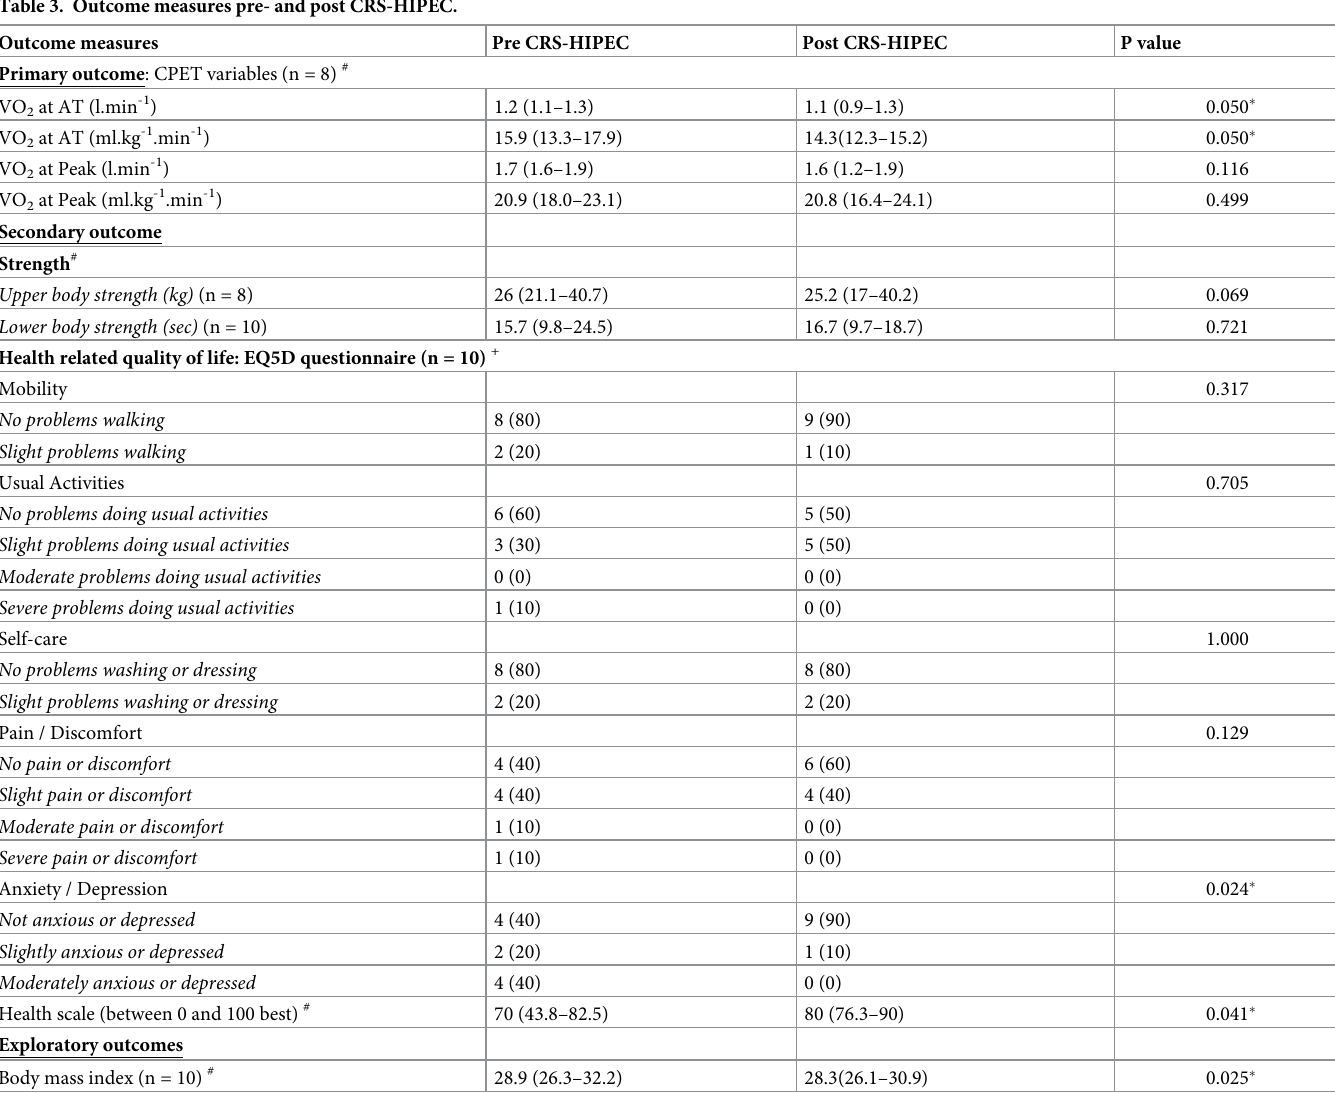
Table 3. Outcome measures pre- and post